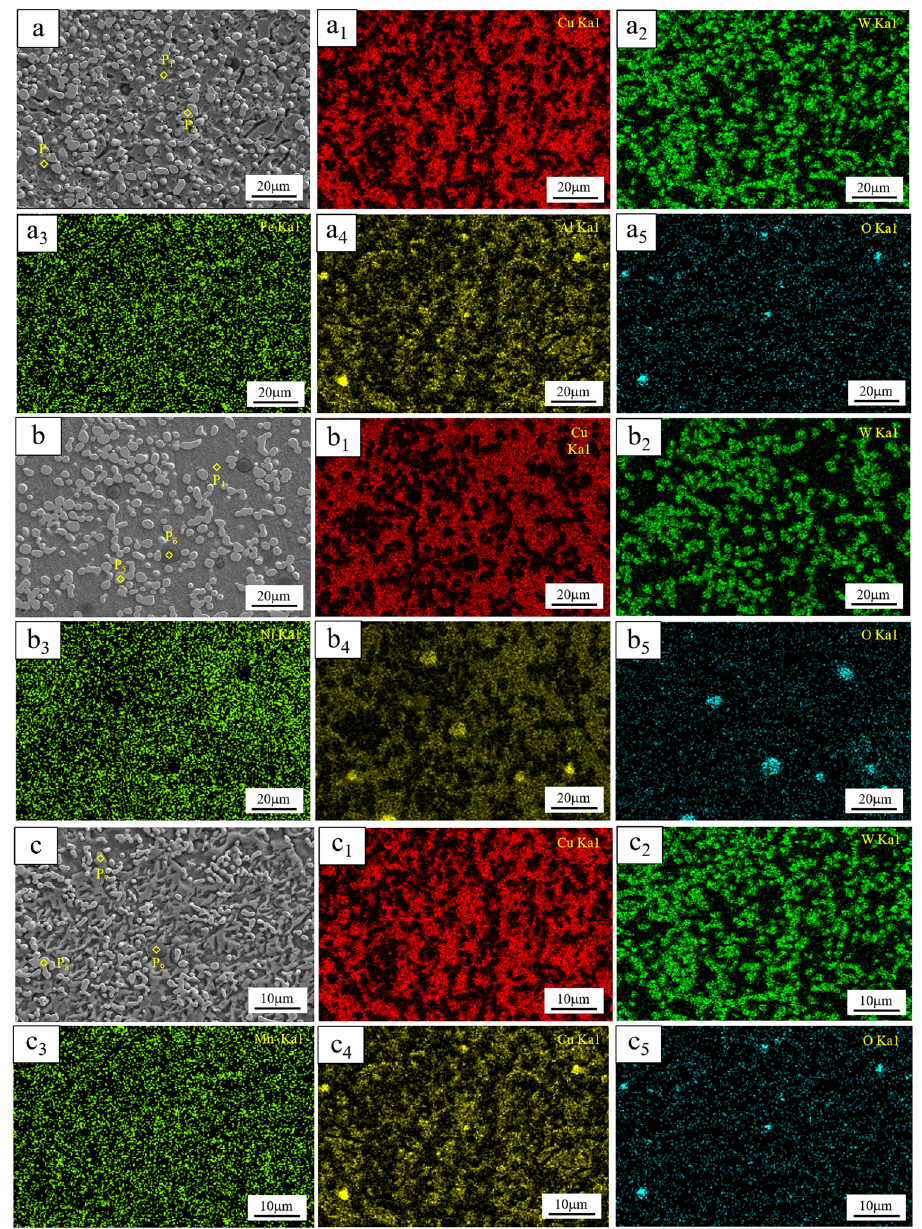
Figure 2: SEM images of WCu composites microalloyed with ( a ) Fe, ( b ) Ni, and ( c ) Mn, and elemental distributions of WCu composites microalloyed with ( a 1 – a 5 ) Fe, ( b 1 – b 5 ) Ni, and ( c 1 – c 5 )